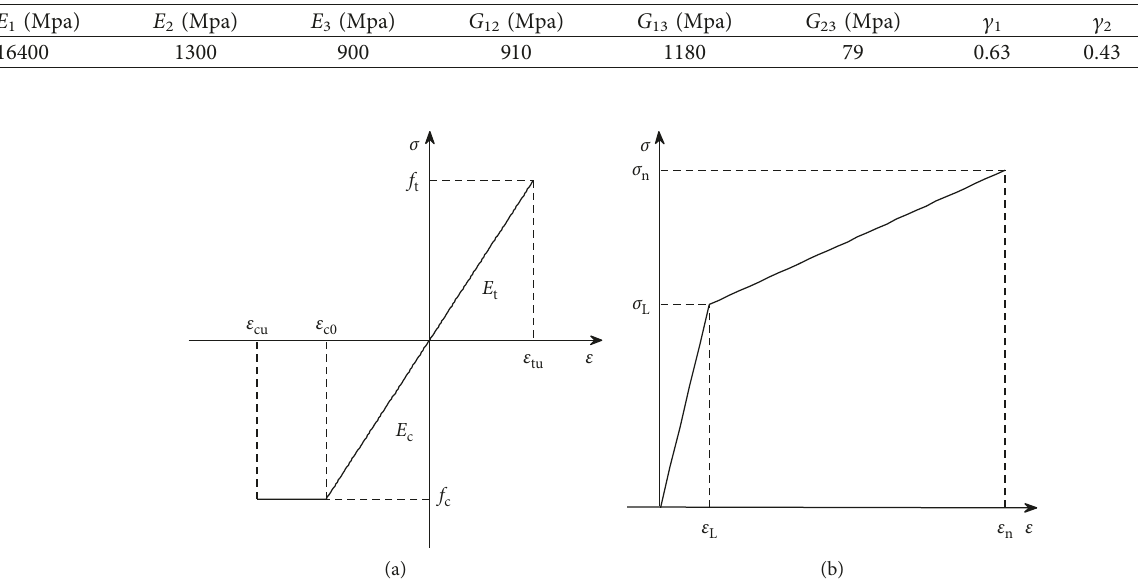
Figure 12: Energy dissipation curves for wood frame models. (a) Unilateral column foot damage (ZJJ). (b) Circumferential column foot damage (ZGW). Table 4: Anisotropic parameters of Douglas fir timber.